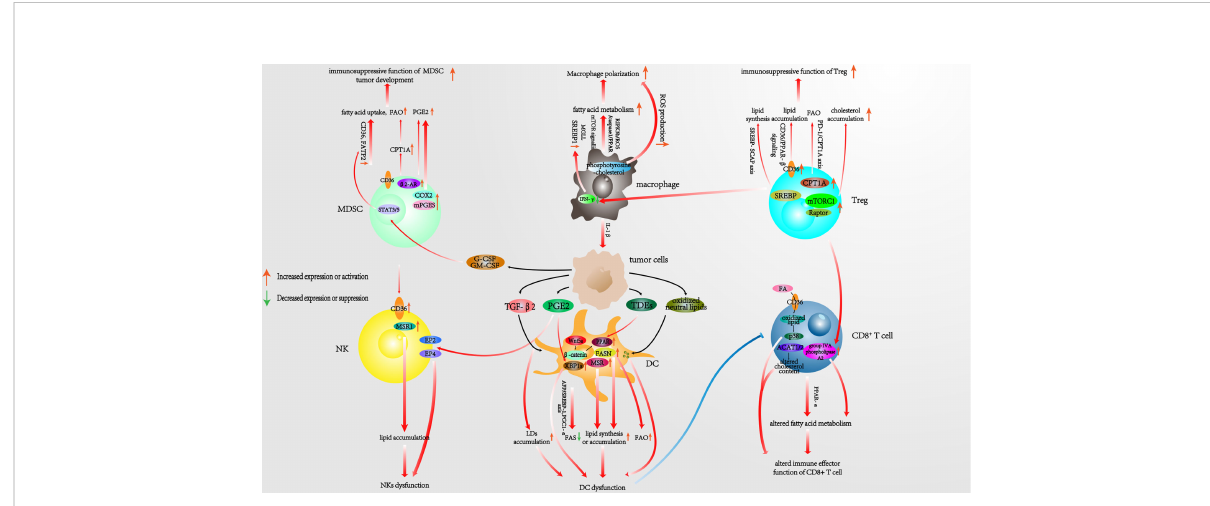
FIGURE 1 Pathways associated with reprogrammed lipid metabolism of in fi ltrating immunocytes in the TME. TME, tumor